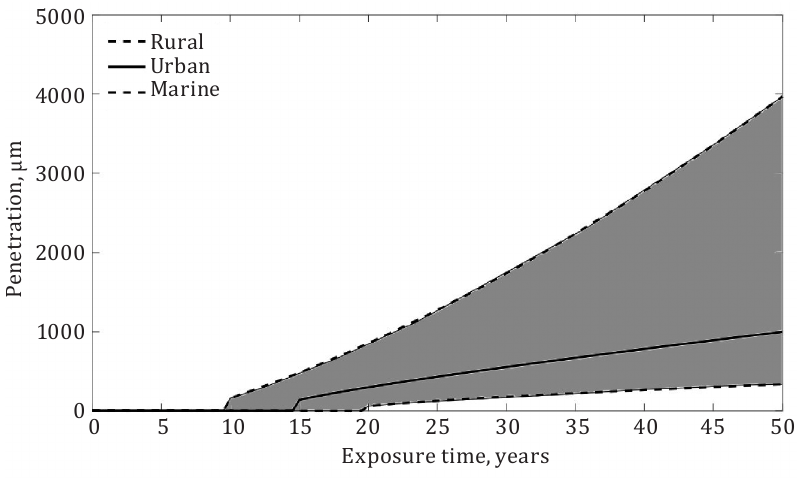
Exposure Figure 11. Corrosion penetration versus exposure time